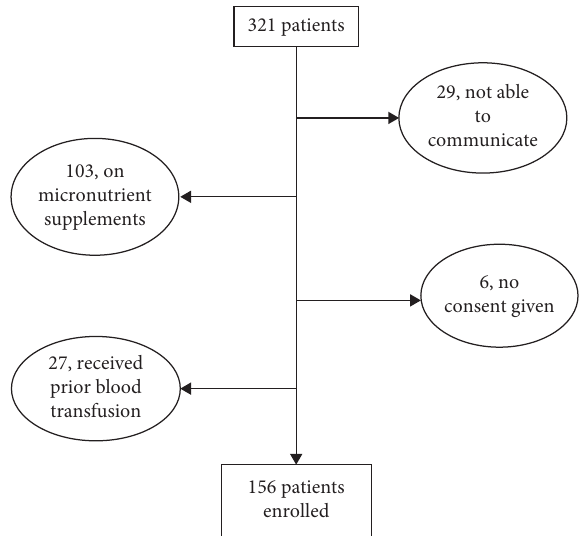
Figure 1: Enrollment Flow